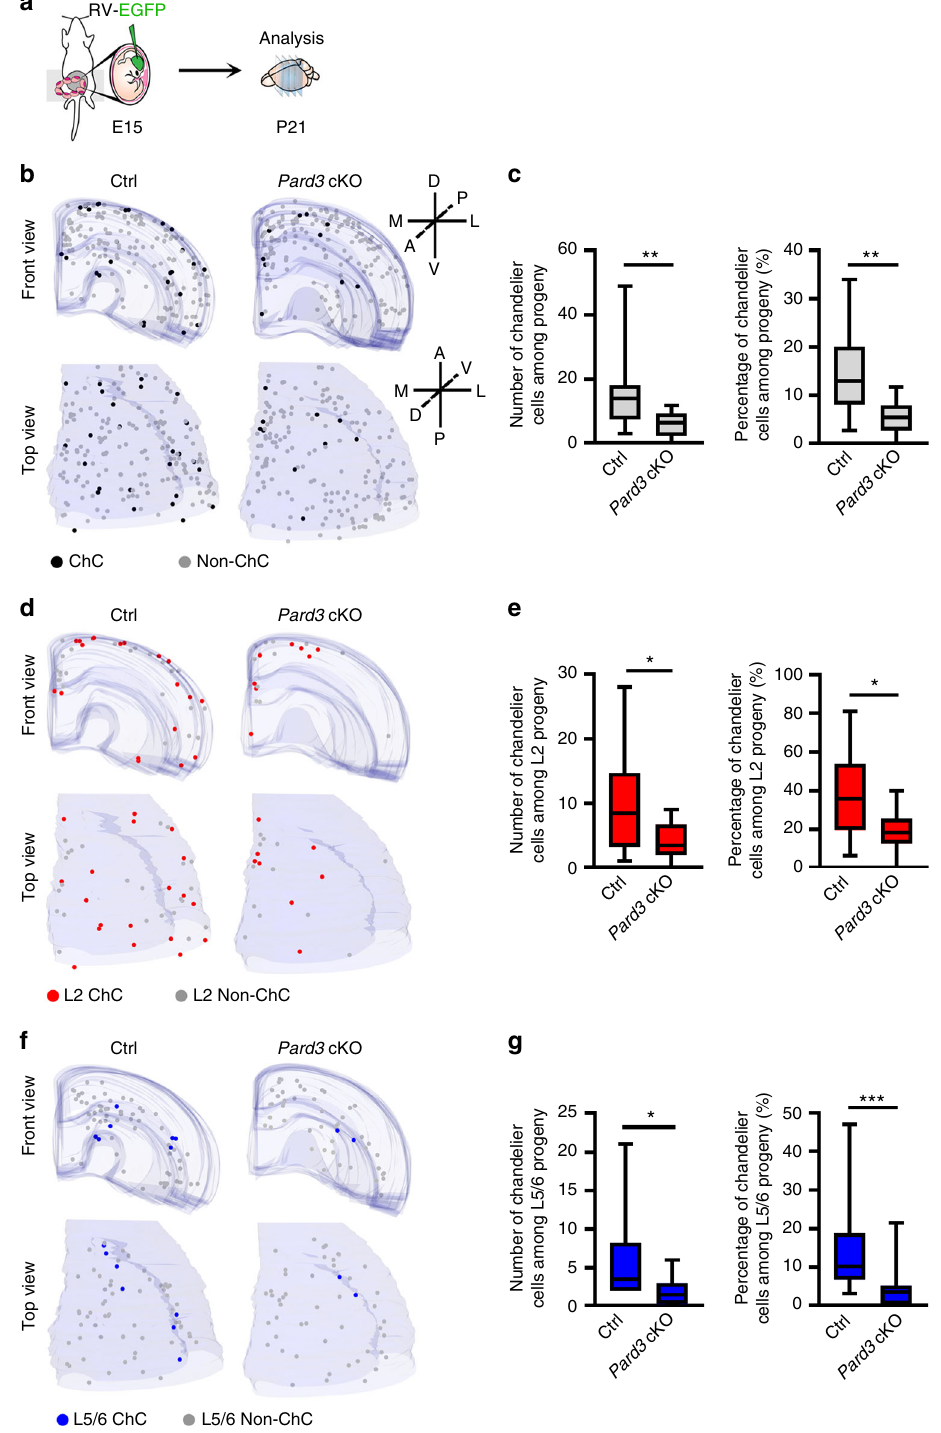
stage. Consequently, this leads to signi fi cant loss of both deep and super fi cial layer chandelier cells. These results suggest that proper RGP asymmetric division is essential for the generation of the correct number and types of neocortical interneurons. In other words, orderly progression of RGP asymmetric divisions supports the proper generation of different neocortical interneuron sub- types. The SVZ harboring IPs is greatly expanded in the MGE 54